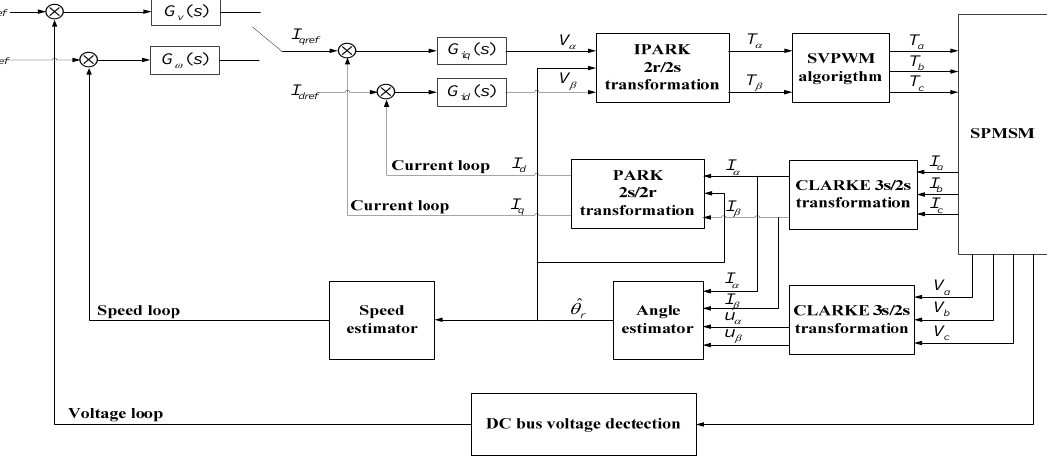
Figure 3. PID ‐ based vector control block diagram. SPMSM: surface ‐ mounted PMSM; SVPWM: Figure 3. PID-based vector control block diagram. SPMSM: surface-mounted PMSM; SVPWM: space space vector pulse width modulation. vector pulse width